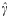
Optimizing sparsity parameter λ and AR coefficient γ^.(A) Running the active set method, with conservatively small estimate γ^, yields an initial denoised estimate (blue) of the data (gray) roughly capturing the truth (red). We also report the correlation between the deconvolved estimate and true spike train as a direct measure for the accuracy of spike train inference. (B) Updating sparsity parameter λ according to Eq (18) such that RSS = σ2
T (left) shifts the current estimate downward (right, blue). (C) Running the active set method enforces the constraints again and is fast due to warm-starting. (D) Updating γ^ by minimizing the polynomial function RSS(γ^) and (E) running the warm-started active set method completes one iteration, which yields already a decent fit. (F) A few more iterations improve the solution further. The obtained estimate (blue) is hardly distinguishable from the one obtained with known true γ (yellow dashed trace, plotted in addition to the traces in A-E, is on top of blue solid line). Note that determining γ^ based on the autocovariance (additionally plotted purple trace) yields a crude solution that even misses spikes (at 24.6 s and 46.5 s).